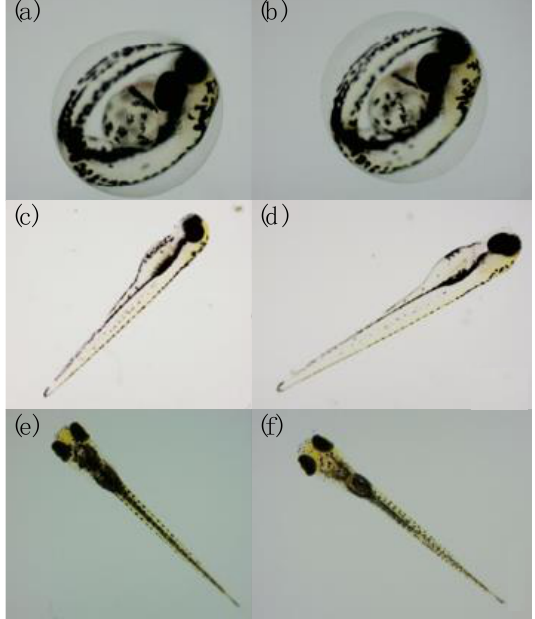
Figure 2. Phenotypes of larvae unexposed ( a , c , e ) and exposed ( b , d , f ) to 27 GHz at 48 hpf ( a , b ); 72 hpf ( c , d ), and 96 hpf ( e , f ). No morphological defects were found. Regarding the hatching of the larvae, there was no statistically significant difference ( p > 0.05) between the controls and the exposed larvae (Figure 3).